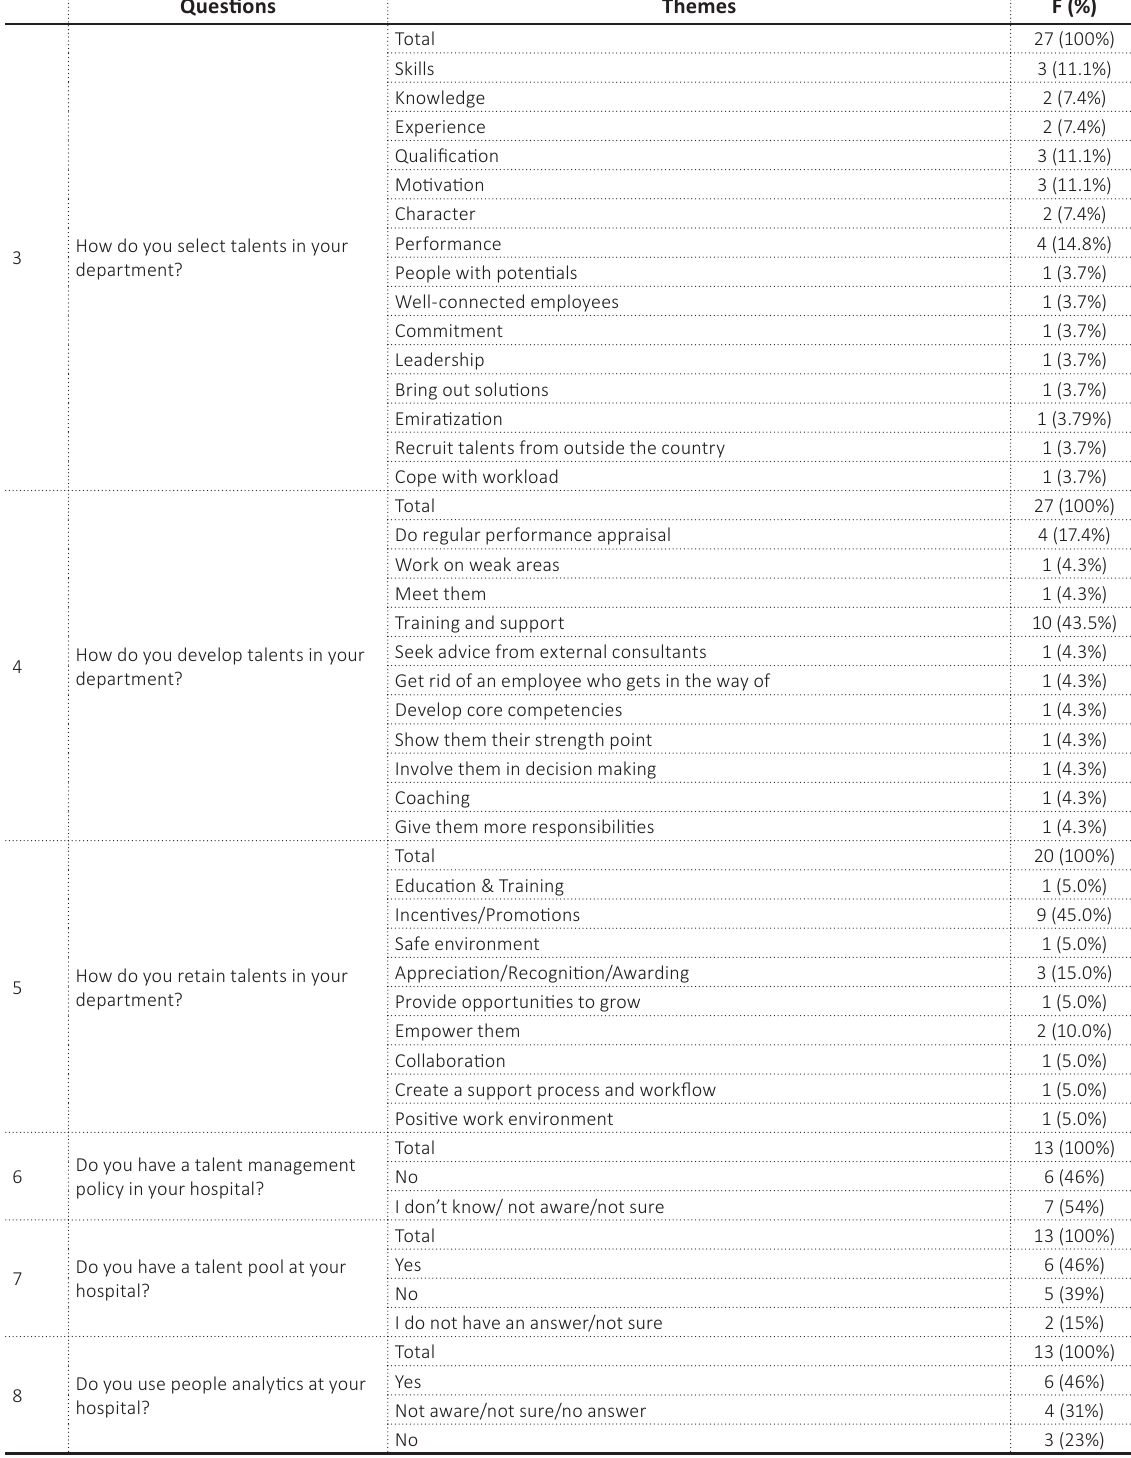
Table A1 (cont.). Thematic analysis of the survey’s